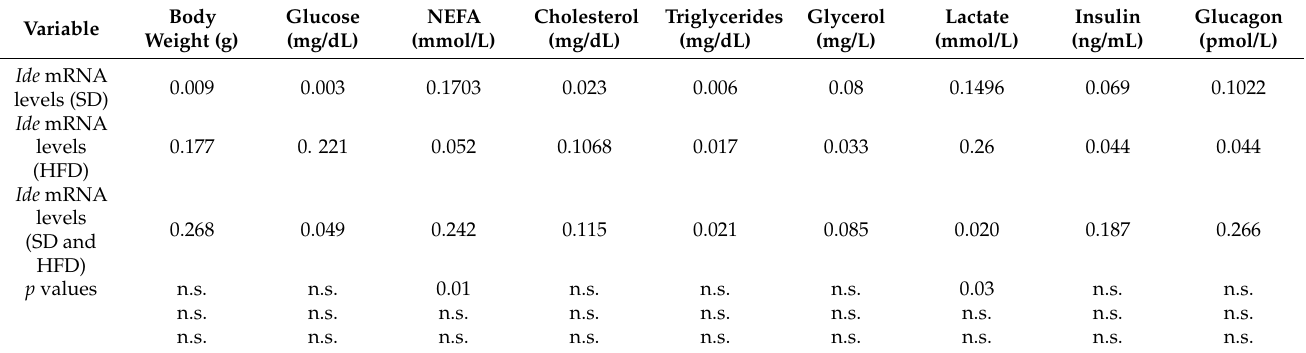
Table A3. R 2 values for muscle Ide mRNA levels and metabolic parameters in mice. n.s., not statistically significant.